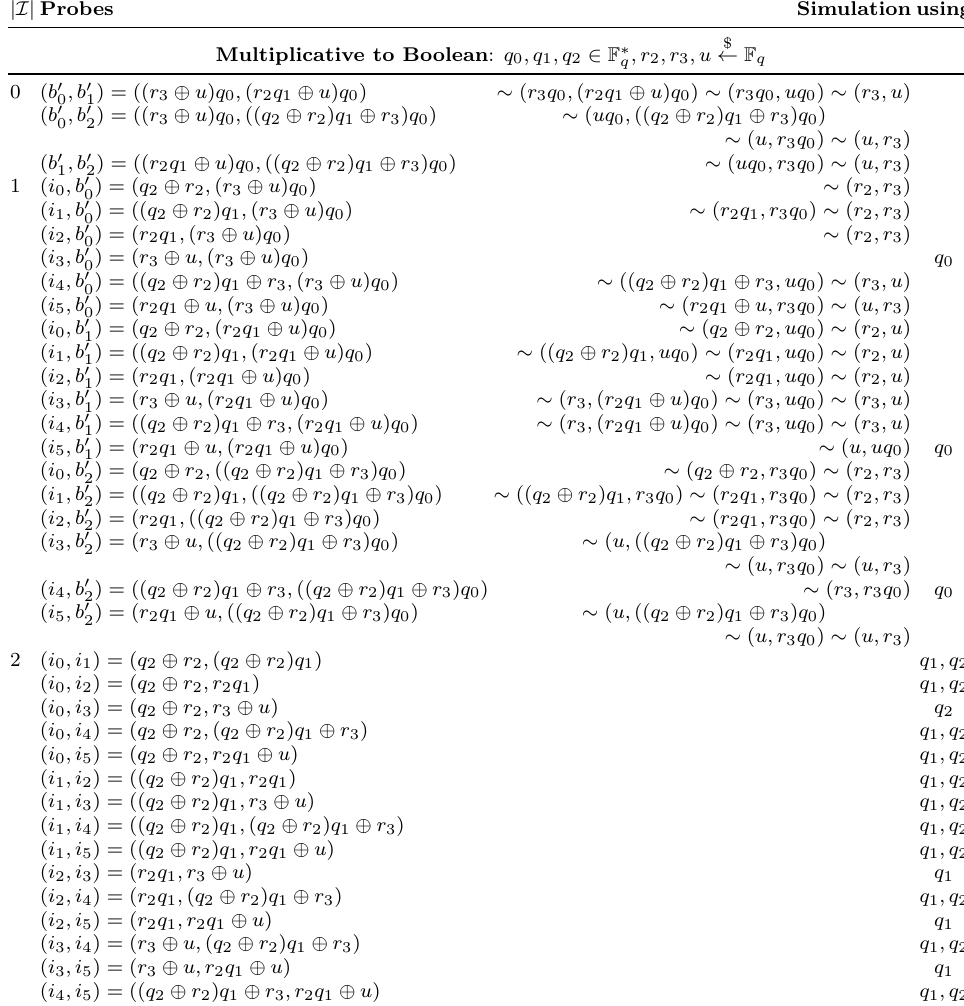
Table 7: Simulation of intermediate probes I and output probes O such that |I| + |O| ≤ d = 2 using |I| input shares for the second-order multiplicative to Boolean